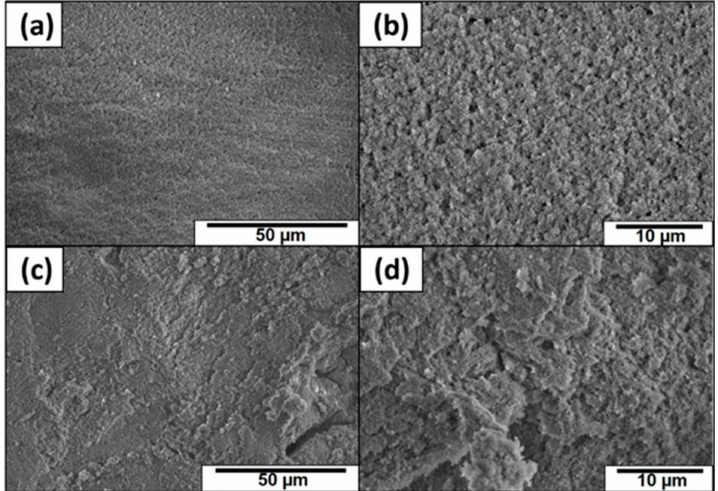
Figure 8. SEM images of the superhydrophobic aluminum surfaces with the Coating A: ( a , b ) surface layer before abrasion at different magnifications; ( c , d ) surface layer after 50 cycles of abrasion at different